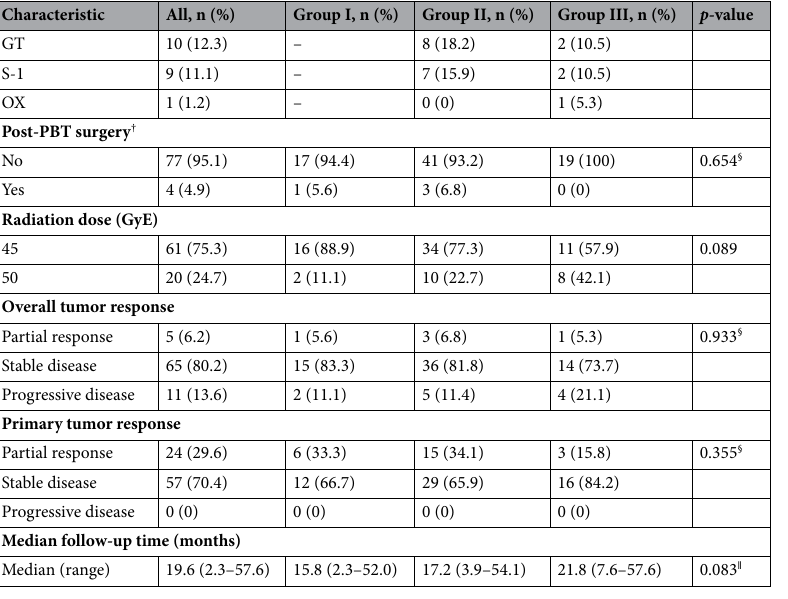
Table 1. Patient characteristics. ECOG PS Eastern Cooperative Oncology Group performance status, N+ lymph node positive, CA 19-9 carbohydrate antigen 19-9, SIB-PBT simultaneous integrated boost-proton beam therapy, FOLFIRINOX 5-fluorouracil, irinotecan, and oxaliplatin, GA gemcitabine plus nab-paclitaxel, GT gemcitabine plus erlotinib, GX gemcitabine plus capecitabine, GP gemcitabine plus cisplatin, S-1 tegafur- gimeracil-oteracil potassium, OX oxaliplatin plus capecitabine, GyE Gray equivalent. *Maximum diameter of the primary tumor. † Pylorus-preserving pancreaticoduodenectomy. ‡ Pearson’s chi-square test. § Fisher’s exact test. ∥ One-way analysis of